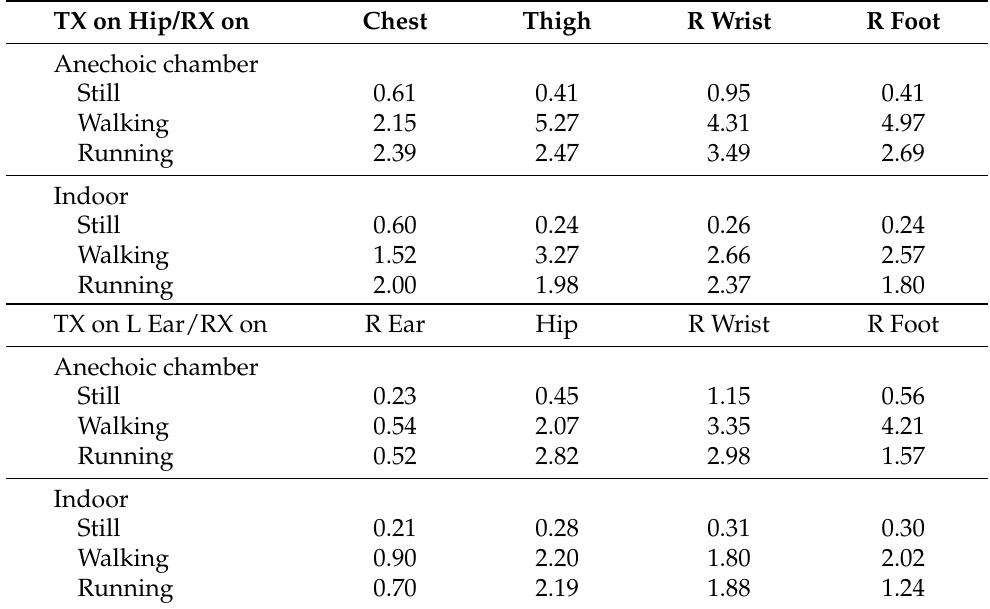
Table 7. Measurement of the shadowing standard deviation (dB) in anechoic chamber and indoor. Various on-body placement configuration assessed. From